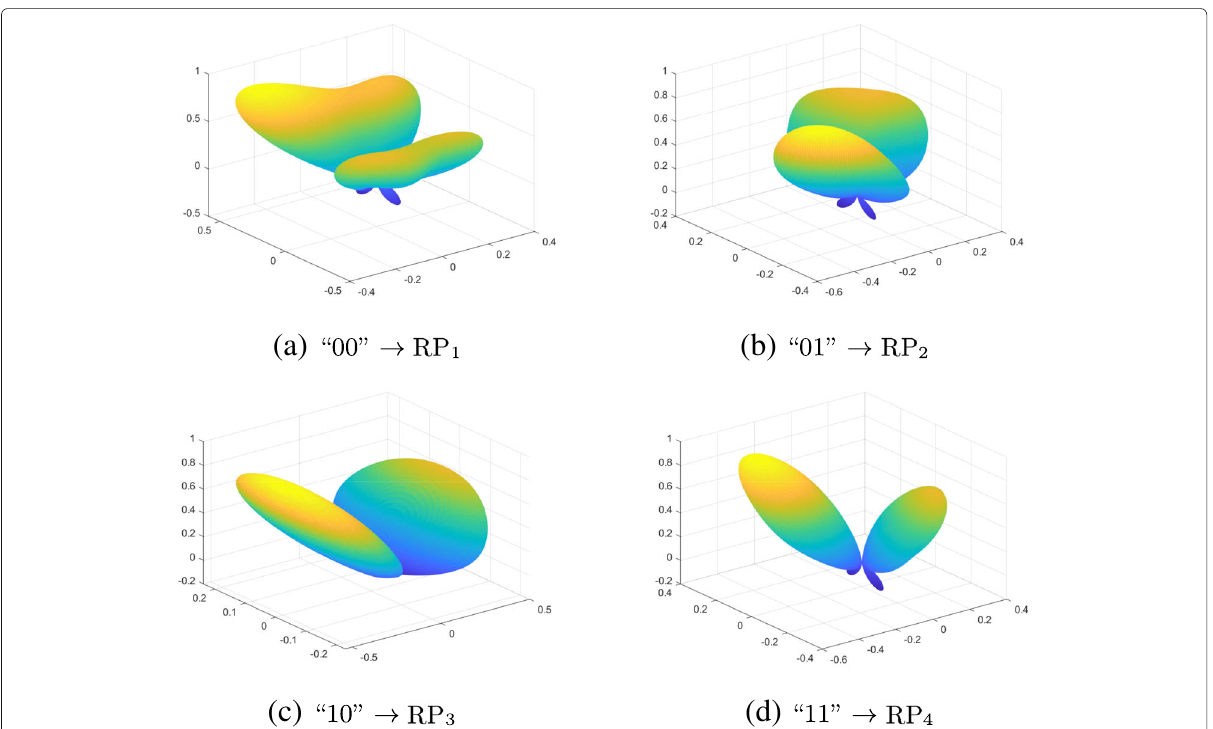
Fig. 1 a – d Illustration of RecAnt-SSK with P = 4. The RPs are obtained from a designed and manufactured antenna that is described in the sequel